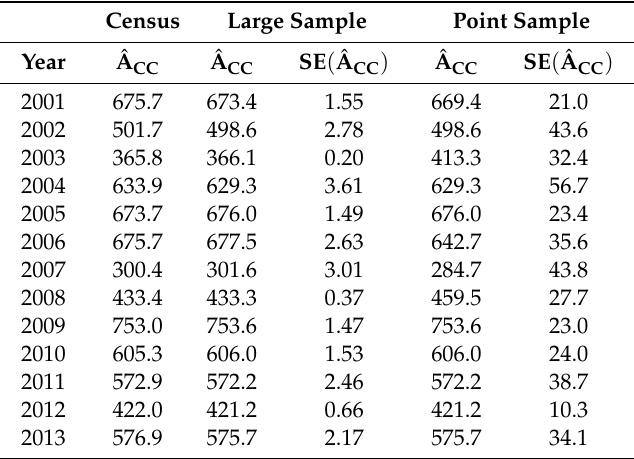
Table 3. Clearcut (CC) area estimates ( census estimates based on entire validation dataset; small sample estimates based on 50% random sample of the validation dataset; point sample estimates based on photointerpretation of 200 randomly selected